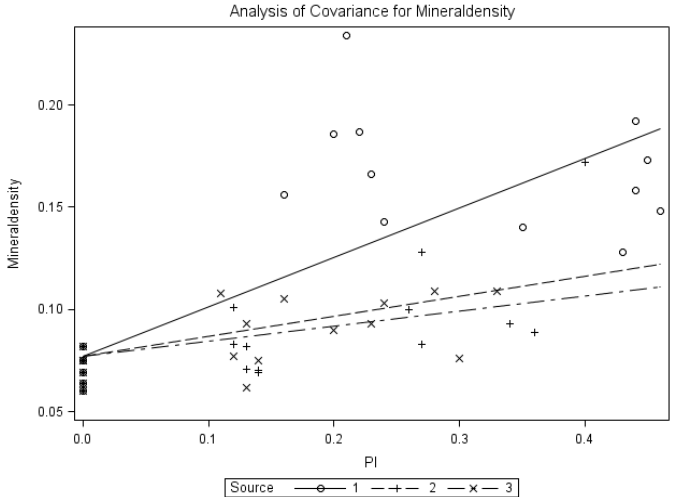
Figure 5. Common-intercept, multiple-linear regression of bone mineral density (mineraldensity; g/cm 2 ) on supplemental P intake of chicks fed diets supplemented with P from monosodium phosphate (MSP; Source 1), brown-seeded pea (BP; Source 2), and Yellow- seeded pea (YP; Source 3). The circular marker represents MSP, the plus marker represents BP, and the multiplication marker represents YB. The common-intercept, multiple-linear regression equation (mean±standard error) was Y = 0.077±0.006+0.242±0.028MSP+0.097± 0.039BP+0.074±0.045YP, R2 = 0.60, p<0.0001; the relative bioavailabilities estimated by slope-ratio were 40.3% and 30.3% for BP and YP,